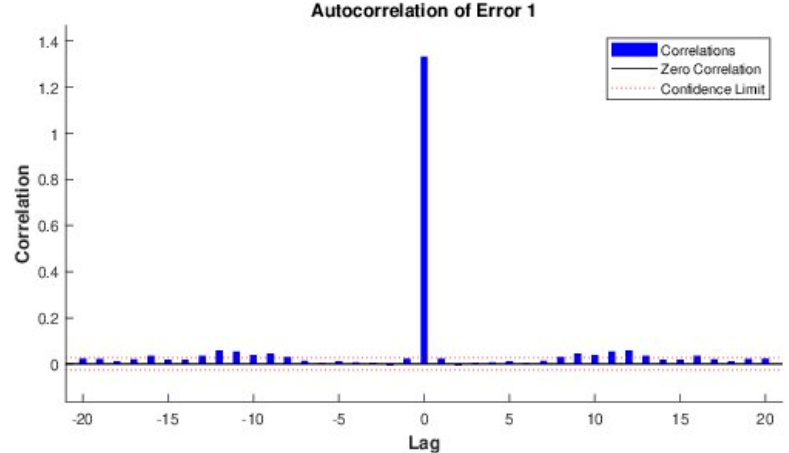
Figure 23. Time series plot of neural network (wind velocity forecasting case).